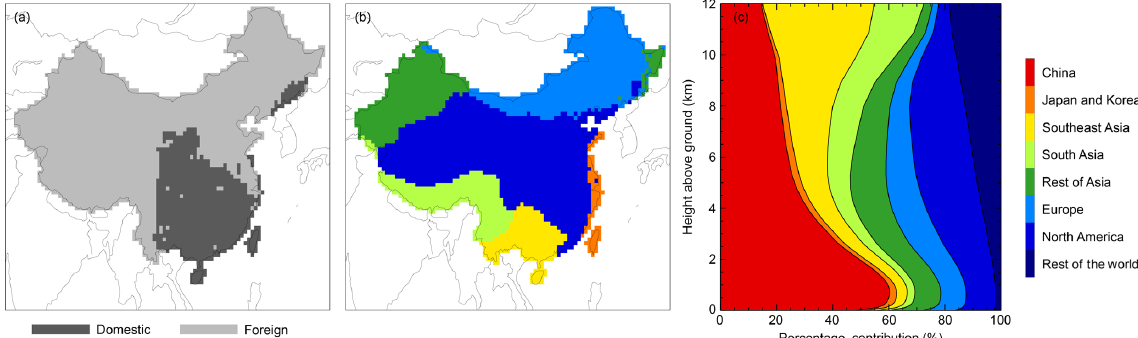
Figure 11. (a) Indication of the largest anthropogenic contributor (domestic or foreign) to surface ozone at individual locations of China. (b) Indication of the largest foreign anthropogenic contributor to surface ozone at individual locations of China. (c) Vertical distribution of percentage contribution of each region to total anthropogenic ozone over